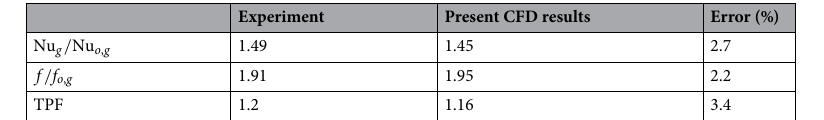
Table 2. Normalized global Nusselt number, friction factor and thermal performance factor comparison between present numerical simulations and experimental results at Re = 4600.